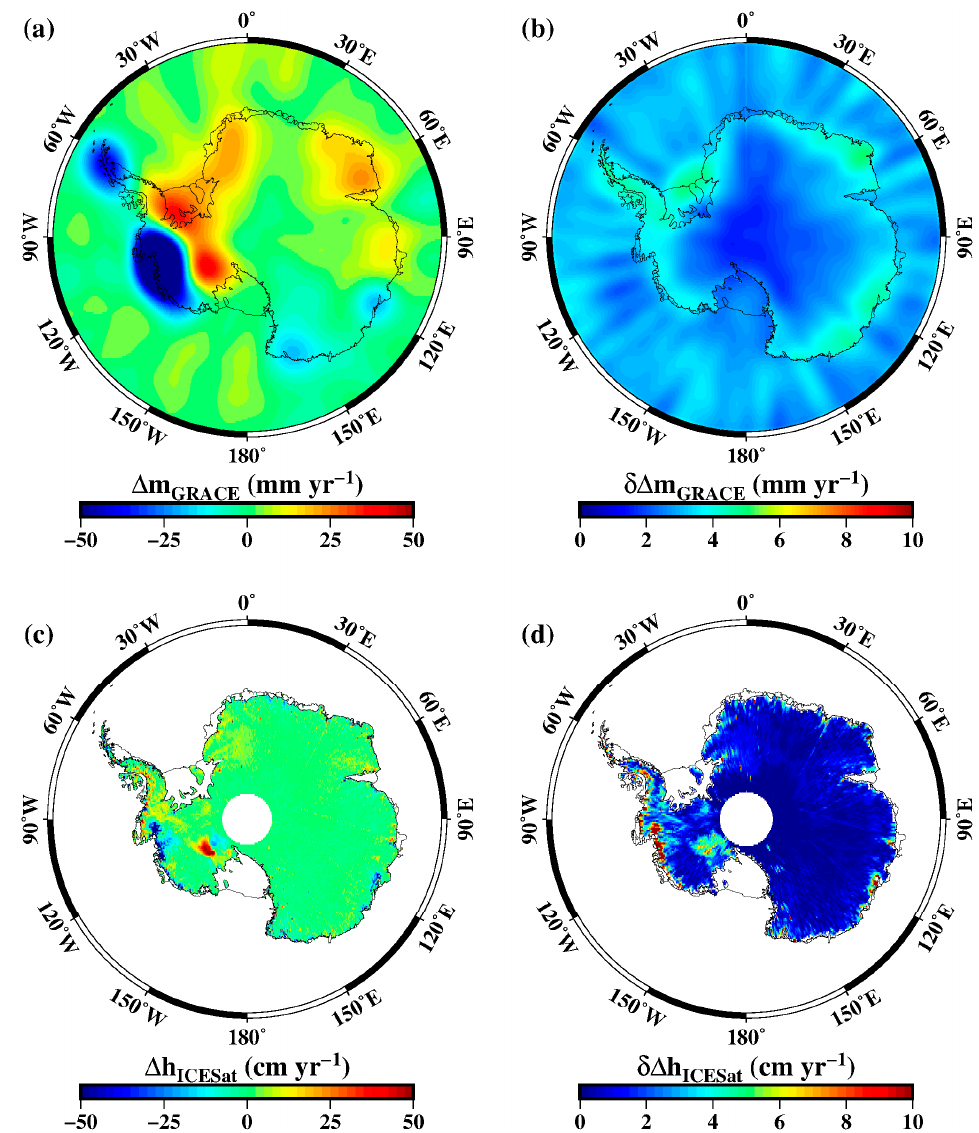
Figure 1. The Gravity Recovery and Climate Experiment (GRACE) observations for ( a ) mass change trends and ( b ) corresponding uncertainties in units of equivalent water height, and the Ice, Cloud and land Elevation Satellite (ICESat) observations for ( c ) elevation change trends and ( d ) corresponding uncertainties over the period February 2003 to October